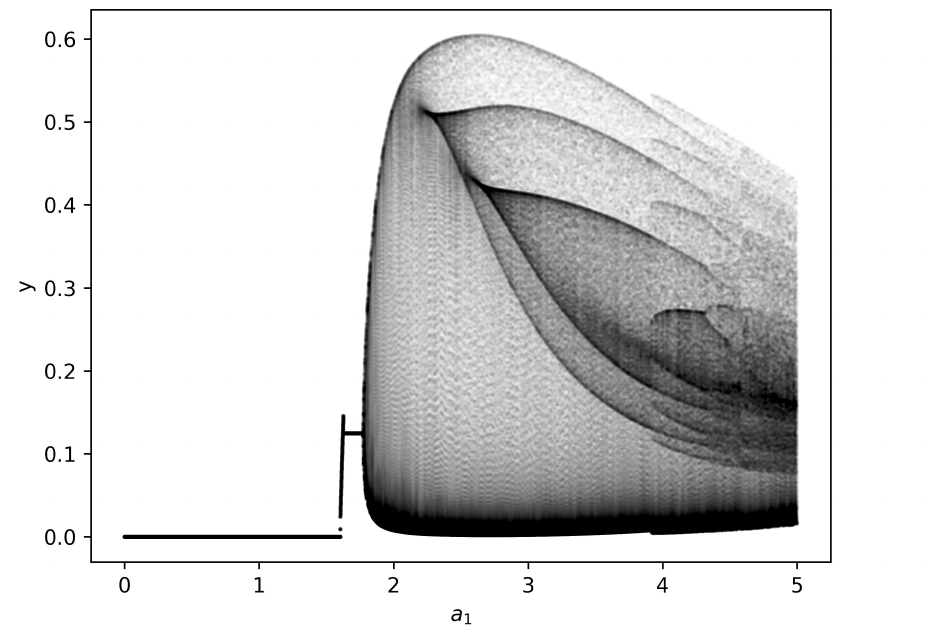
Figure 2. Orbit diagram depicting the attractors of y as a function of a 1 . Other parameter values as in the original Hastings–Powell